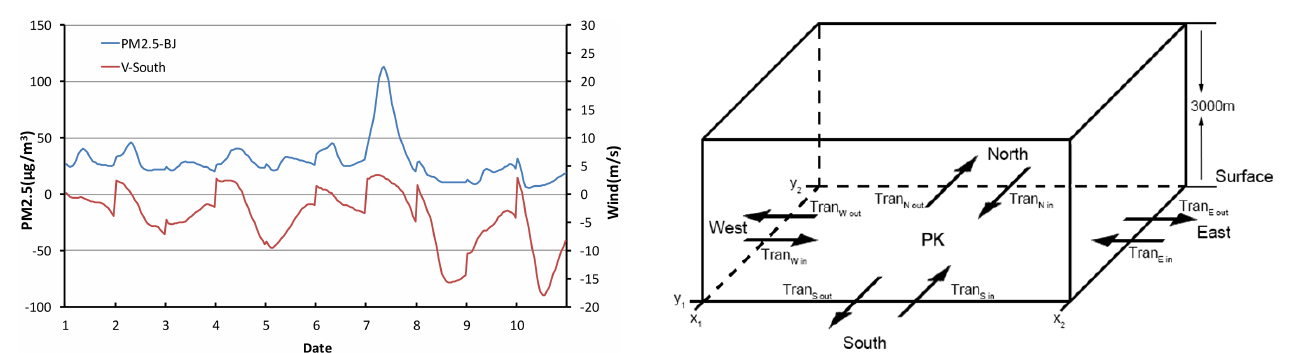
Figure 6. Hourly variations in PM 2 . 5 (µgm − 3 ) in BJ and mean southerly wind speed (negative for northerly wind) for the region to the south of BJ, 1–10 December 2013.